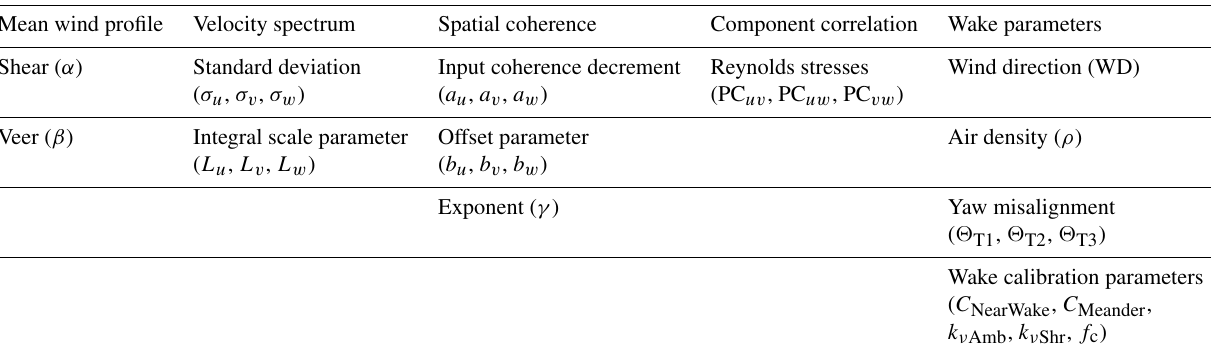
Table 2. Wind inflow and wake parameters. Mean wind